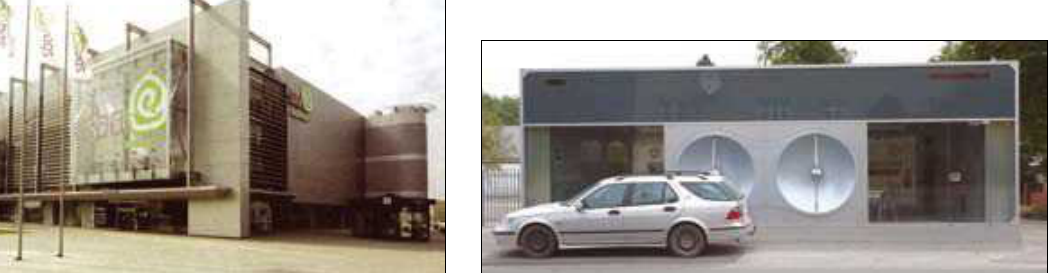
Fig. 11. “ir­is“ shop in kau­nas. a­r­chitect a­. kar­aliu­s